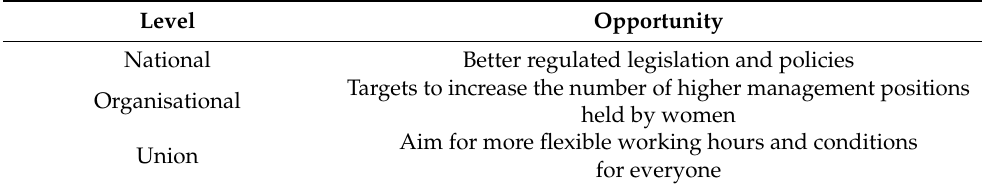
Table 3. Examples of opportunities that would benefit women in construction